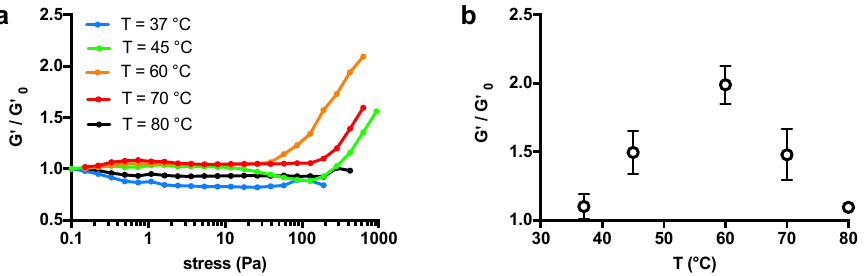
Figure 5. Effect of the temperature on the nonlinear behavior of chitosan–genipin hydrogels. ( a ) Dependence of the ratio G (cid:48) max / G (cid:48) 0 from stress for genipin-based chitosan hydrogels formed at 37 ◦ C (blue), 45 ◦ C (light green), 60 ◦ C (orange), 70 ◦ C (red) and 80 ◦ C (black), respectively. ( b ) Highest value of G (cid:48) max / G (cid:48) 0 reached at different temperatures. Conditions: polymer concentration = 1% (m/V), glucosamine-to-genipin molar ratio (R D/G ) = 90.